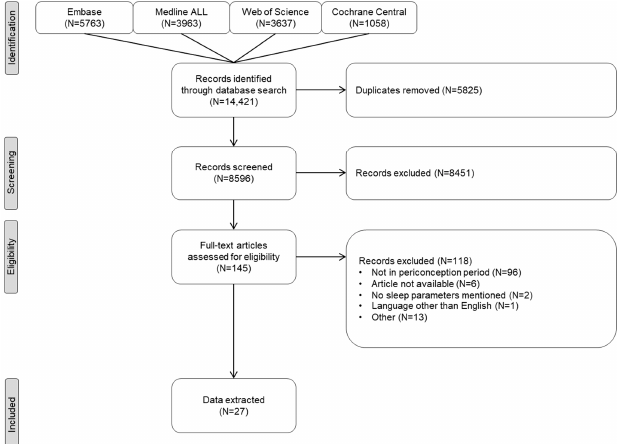
Figure 1. PRISMA flow diagram of the article selection process in a systematic review of maternal sleep problems in the periconceptional period. Other reasons included: case-control study (5), sleep was not studied as exposure (3), letter (1), no association with sleep was studied